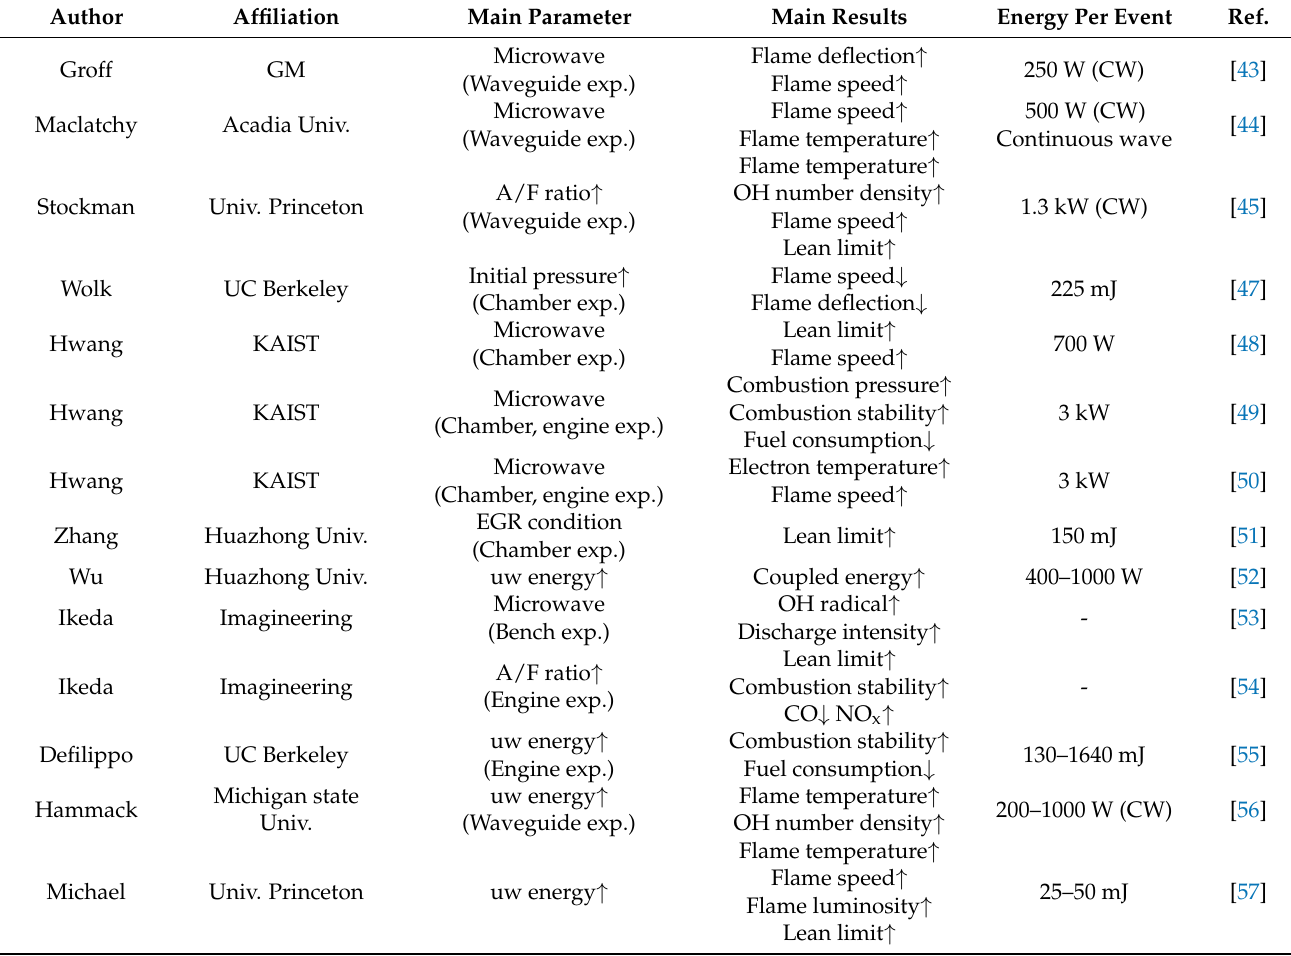
Table 4. Summary of effect of microwave-assisted plasma ignition on